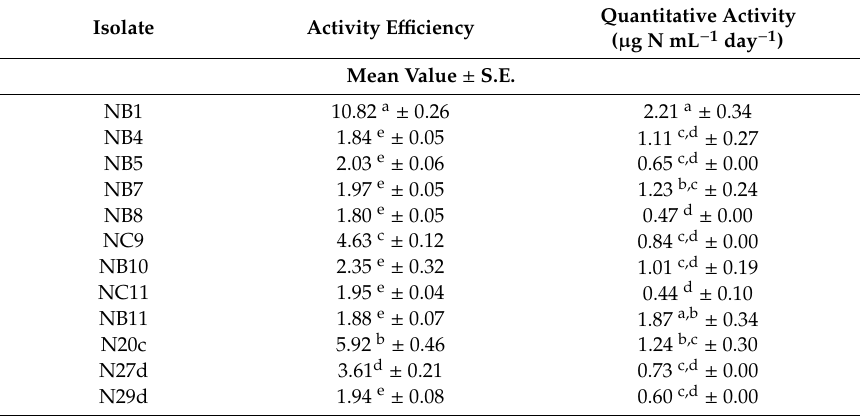
Table 2. Nitrogen-fixation e ffi ciency and the BNF quantification of diazotrophic